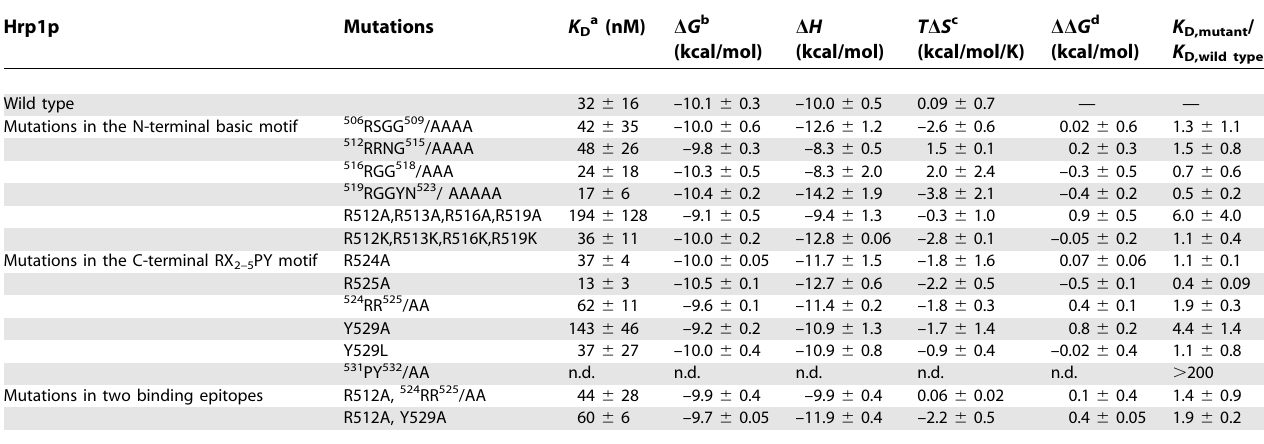
Table 2. Summary of ITC Data for Kap104p Binding to Hrp1p Mutants